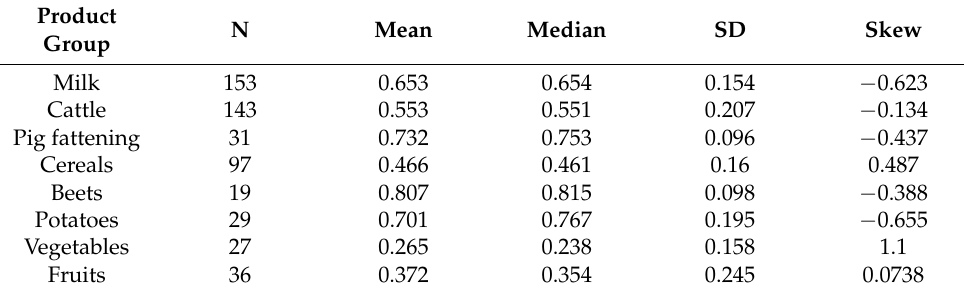
Table A5. Summary environmental efficiency scores ( −